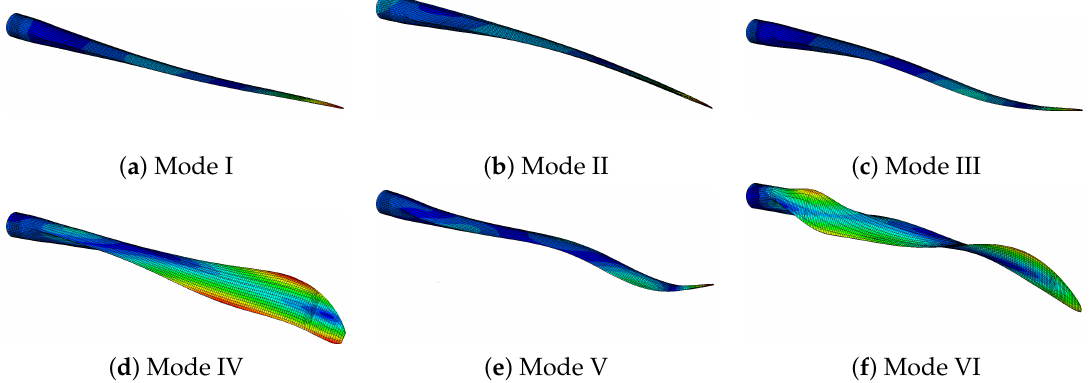
Figure 14. Eigenmodes of the free–free configuration of the wind turbine blade simulated in